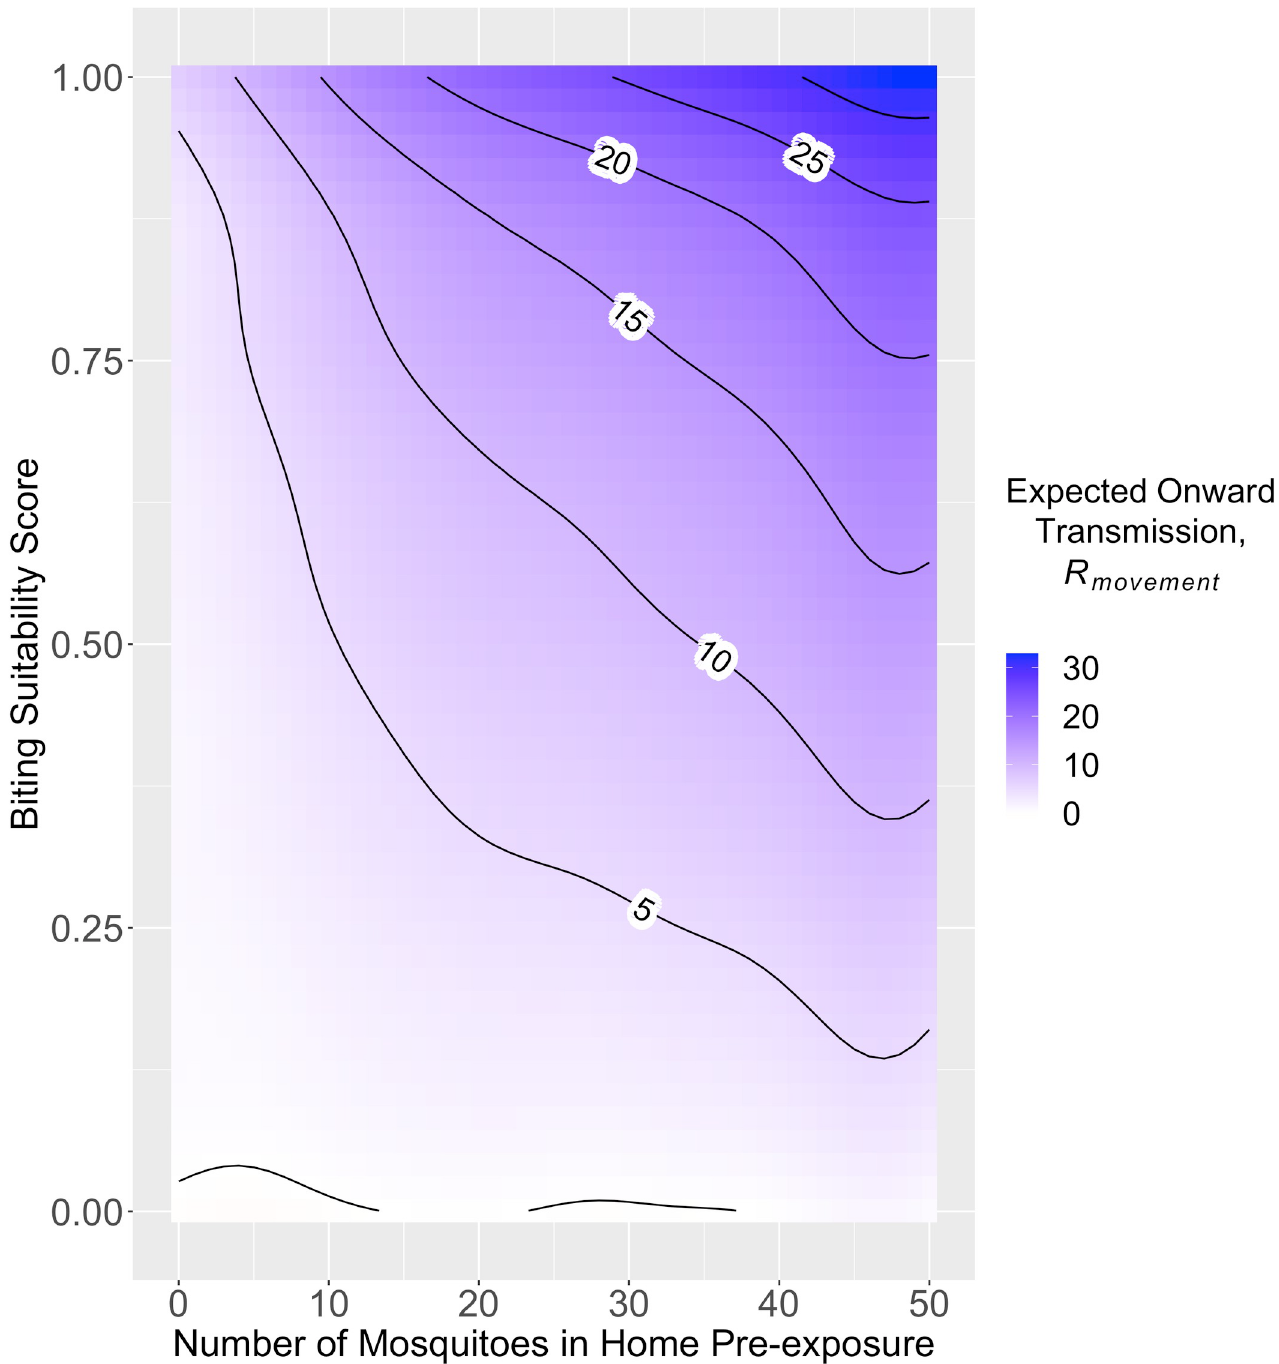
Fig 4. Predicted contribution to onward DENV transmission ( R movement ) based on a GAM with predictor variables number of mosquitoes in home pre- exposure, biting suitability score, and their interaction. The predicted values of onward transmission based on biting suitability and number of mosquitoes at home pre-exposure, presented as a heatmap with